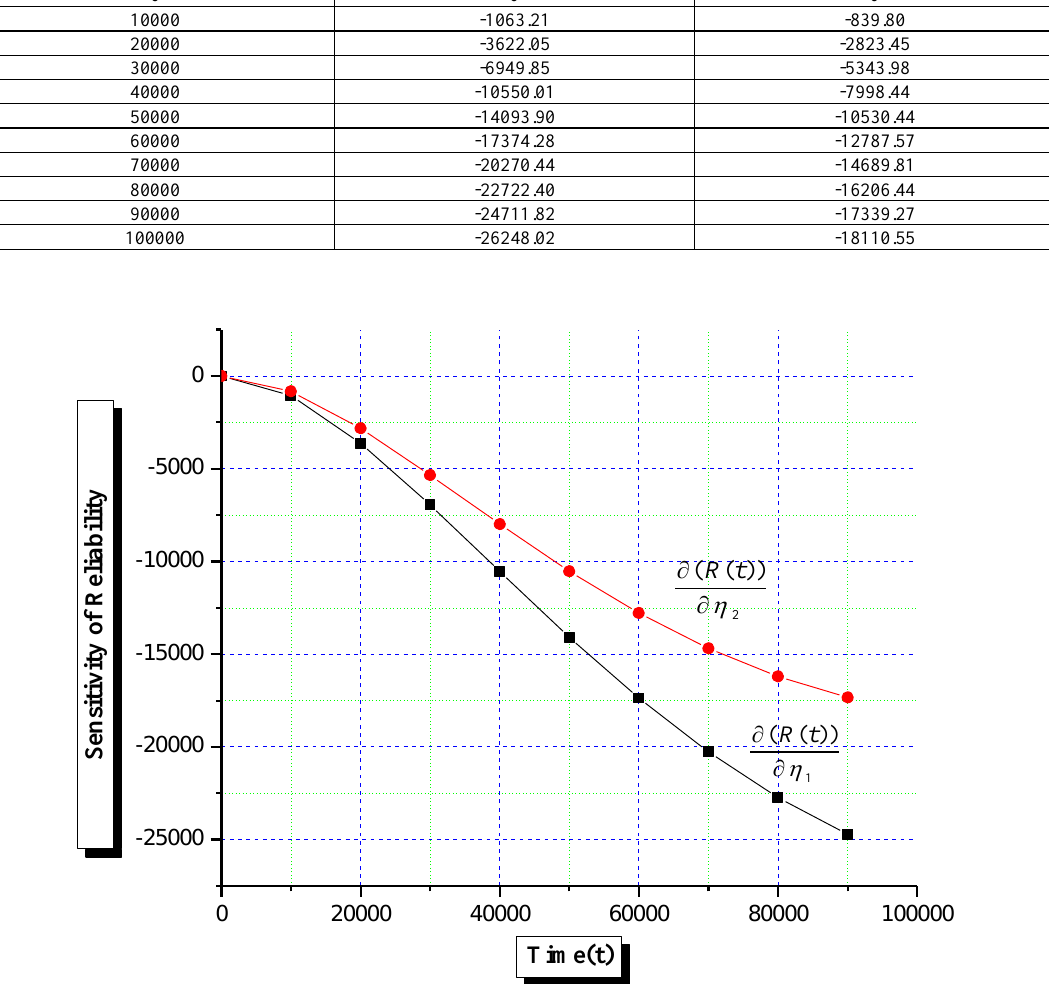
Figure 6. Sensitivity of reliability w.r.t.